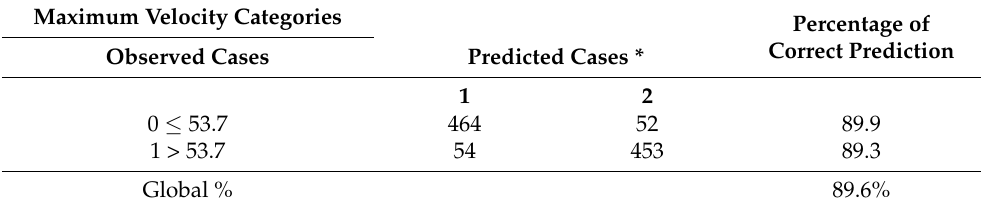
Table 7. Predicted case table.